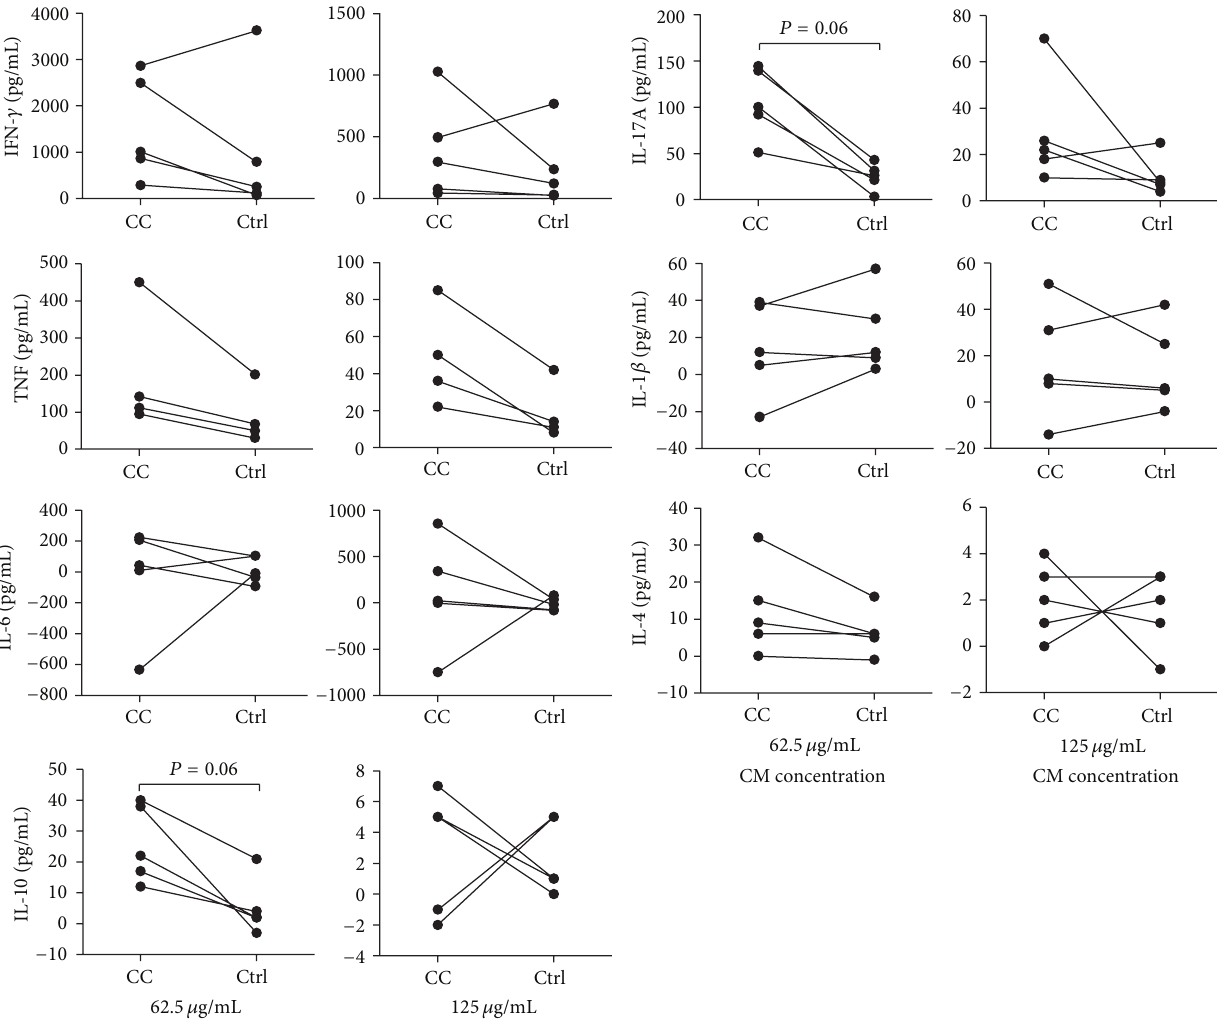
Figure 2: Luminex analysis for IL-1 𝛽 , IL-4, IL-6, IL-10, IL-17A, IFN- 𝛾 , and TNF production by anti-CD3 plus anti-CD28 stimulated CD4 +